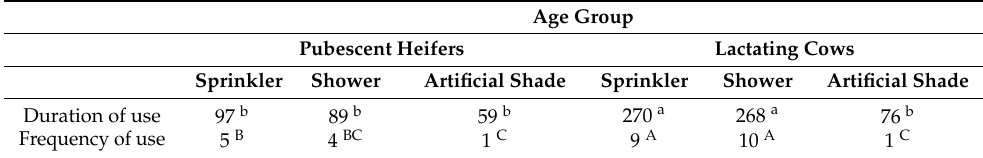
Table 4. Treatment × breed and treatment × age interactions on frequency and duration (minutes) of use of the systems heat-stress-reduction systems.